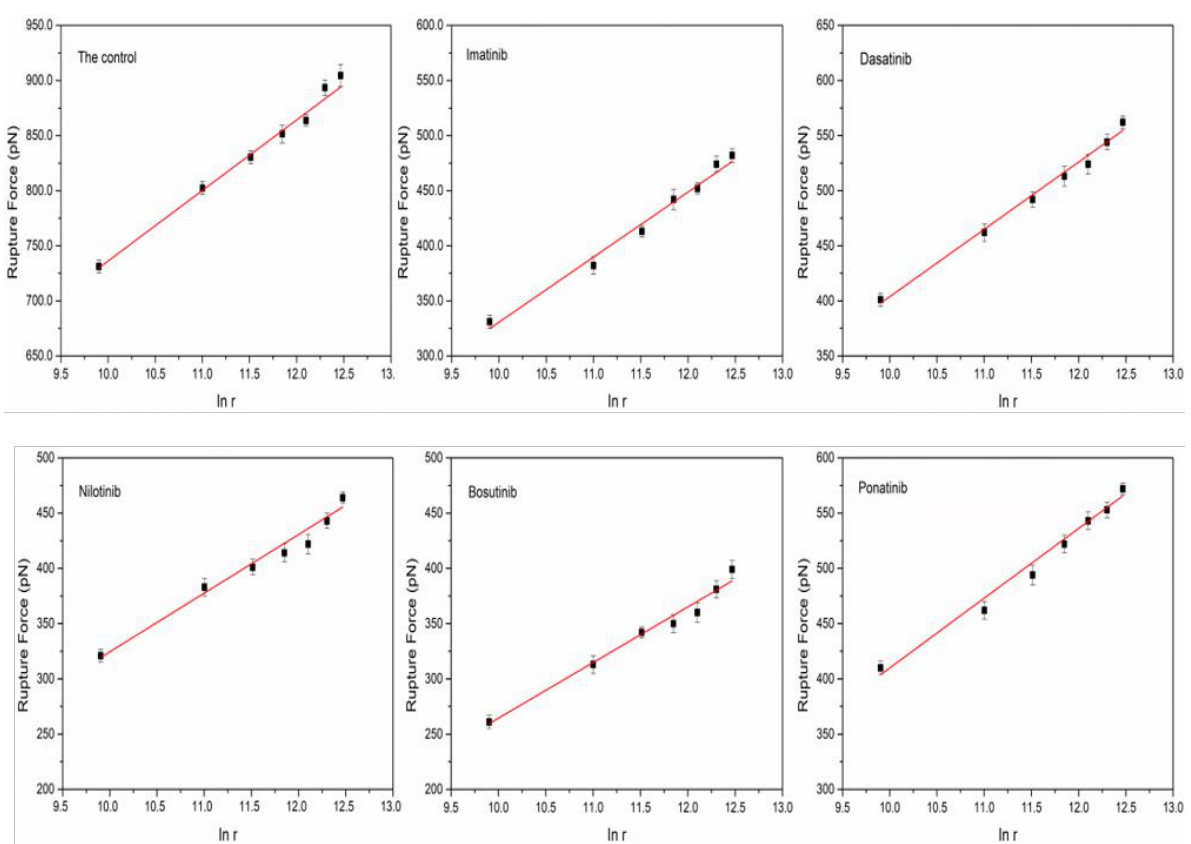
Figure 7. Plots of the most probable rupture forces against the logarithm of loading rates I n ( r ).